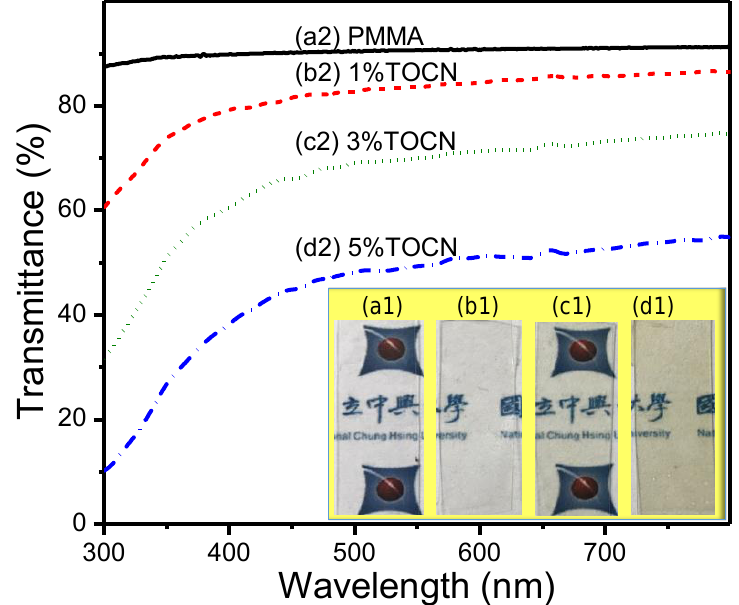
Figure 9. ( a1 – d1 ) Apparent images and ( a2 – d2 ) ultraviolet visible (UV–Vis) spectra of pristine PMMA and composite